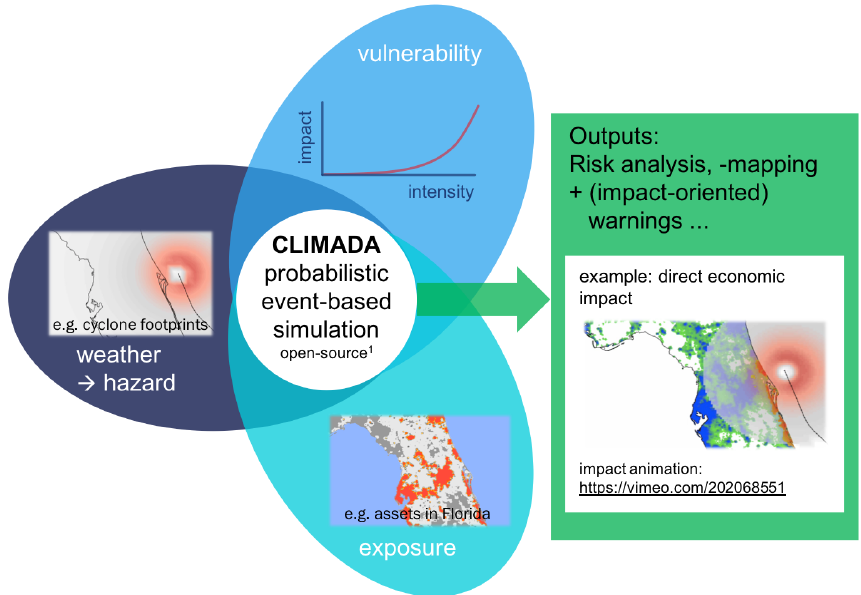
Figure 1. In essence, CLIMADA implements the concept of risk as in IPCC (2014). CLIMADA combines hazard (e.g. a tropical cyclone wind footprint, leftmost inset), exposure (e.g. an asset distribution, centre bottom inset), and vulnerability (functional relationship between hazard intensity and impact, centre at the top) to calculate risk. Severity, measured, for example, as direct economic impact, is rendered by the red dots on the right panel. Please refer to the link provided for an animated